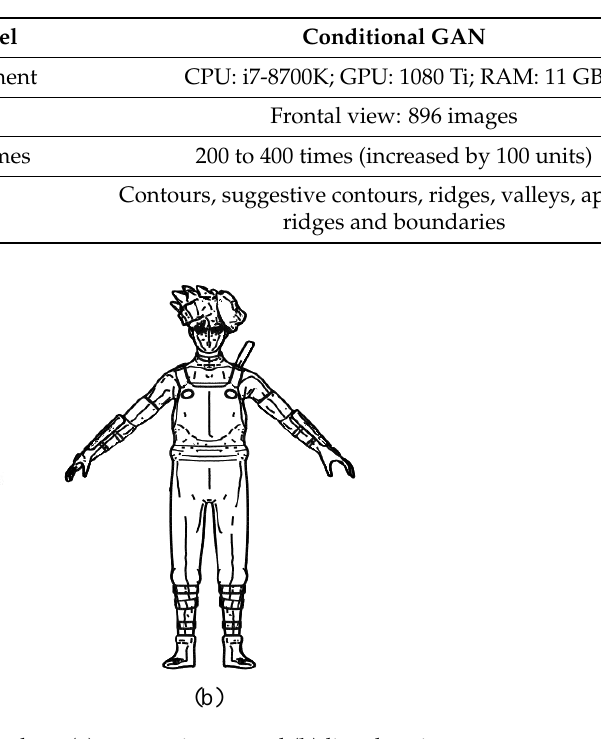
Figure 11. Example of training data: ( a ) cartoon image and ( b ) line drawing.